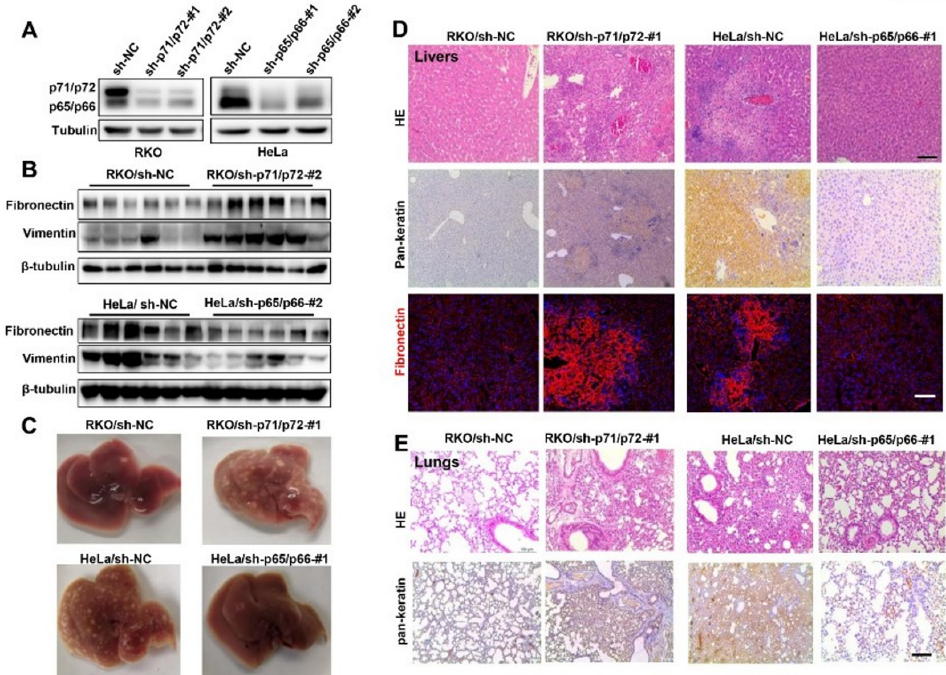
Figure 3. NUMB isoforms distinctly controlled tumor migration and metastasis in mice. ( A ) Western blot analysis of NUMB isoform knockdown in stable RKO cells or HeLa cells expressing sh-p71/72 (#1 and #2) or sh-p65/p66 (#1 and #2), respectively. ( B ) Stable RKO cells (sh-NC and sh-p71/p72-#2) and HeLa cells (sh-NC and sh-p65/p66-#2) were laterally abdominally injected into nude mice. Three weeks after the injection, livers were harvested, and protein extracts were examined by Western blotting with indicated antibodies. ( C ) Stable RKO cells (sh-p71/p72-#1 and sh-NC) and stable HeLa cells (sh-NC and sh-p65/p66-#1) were subcutaneously injected into nude mice. Mice were killed at four weeks after the injection, and representative images of livers were shown from the indicated groups. ( D ) Representative HE staining, IHC staining of pan-keratin and immunostaining of fibronectin were shown from indicated groups. Scale bar is 100 μ m. ( E ) Representative HE staining and immunohistochemical staining images of lung sections prepared from the indicated groups. Scale bar is 100 μ m.